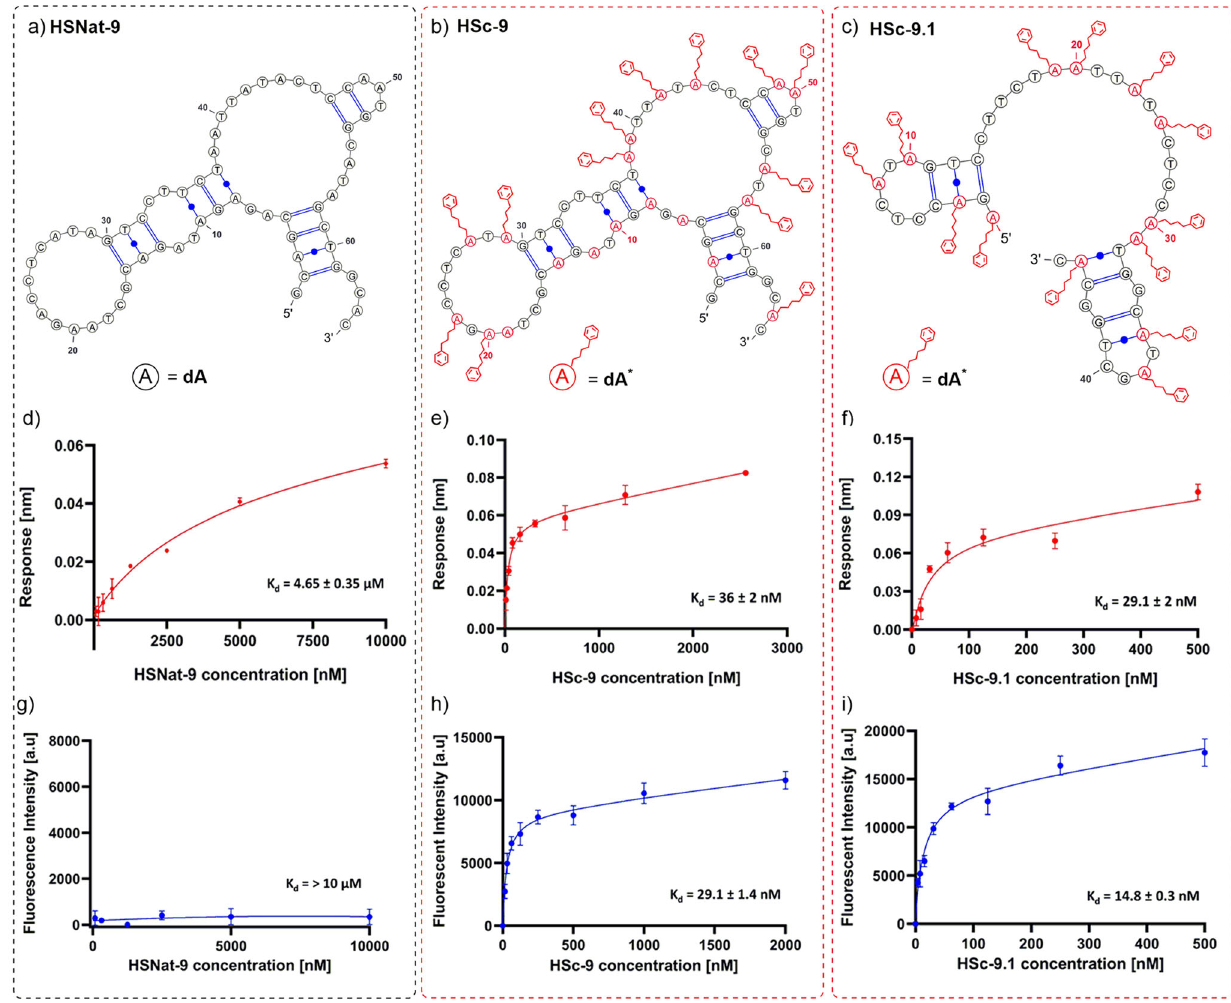
Fig. 5 Binding af fi nity results of the natural HSNat-9 sequence, modi fi ed HSc-9 aptamer and the modi fi ed truncated HSc-9.1 aptamer. a – c The potential predicted secondary structures for the HS-9 aptamers as determined by MFold. PhBu-modifed dA* bases with side chains are highlighted in red for visualisation. d – f The corresponding binding curves for HS-9 aptamers as determined by BLI, different aptamer concentrations were used as analyte and the steady state binding af fi nity [K d ] was calculated. g – i The corresponding binding curves for HS-9 aptamers as determined by the fl uorescent-plate- based binding assay. The raw fl uorescent data were exported into Graph Prism and the binding af fi nity [K d ] of each aptamer calulated. Error bars represent the average values of two independent experiments.